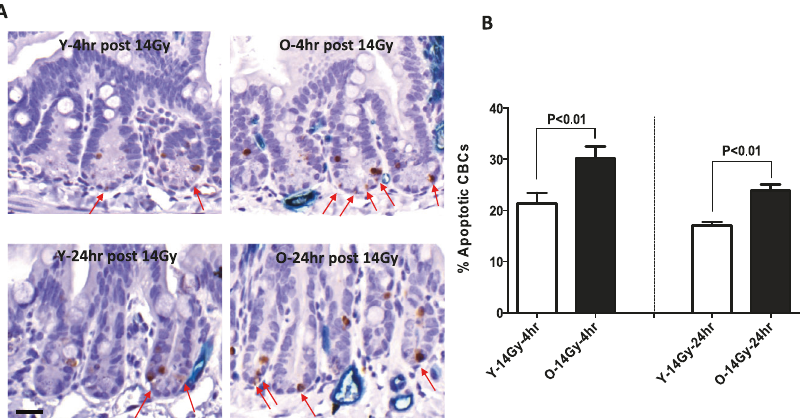
Fig. 4 Apoptotic CBCs in response in young vs old mice at 4 h and 24 h post-RT. A The sections of proximal jejunum were obtained from young adult and old mice sacri fi ced at 4h (upper left and center panels) and 24 h post 14 Gy irradiation(bottom left and center panels). The apoptosis was detected with cleaved caspase-3 by IHC staining. Apoptosis Index = positive apoptotic CBC/total CBC per jejuna circumference x 100%. Red arrows indicate apoptotic CBCs. B Quanti fi cation of percent apoptotic CBC per jejuna circumference. Data are presented as means ± SD. N = 3 mice/group, 10 circumferences per mouse. ** P < 0.01 Y-14 Gy-4 h vs O-14 Gy-4 h and Y-14 Gy-24 h vs O-14 Gy-24 h, Student ’ s t -test. Scale bar 20 μ m.